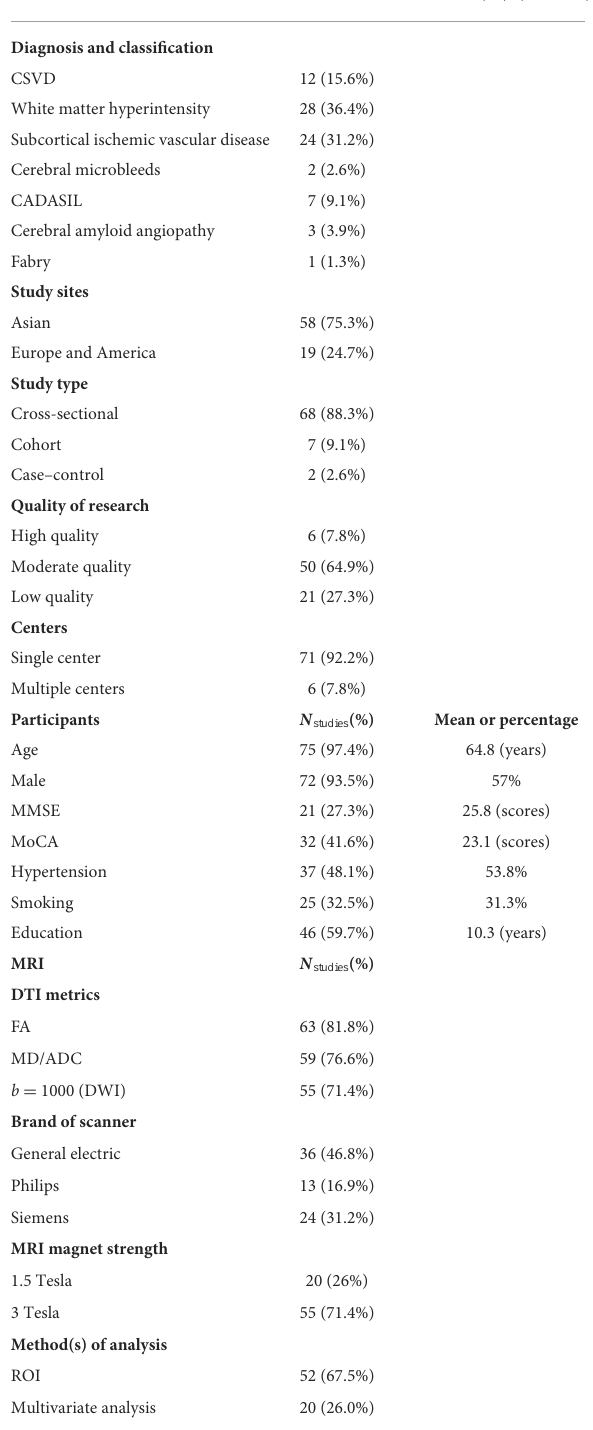
TABLE 1 Summarized characteristics of the included